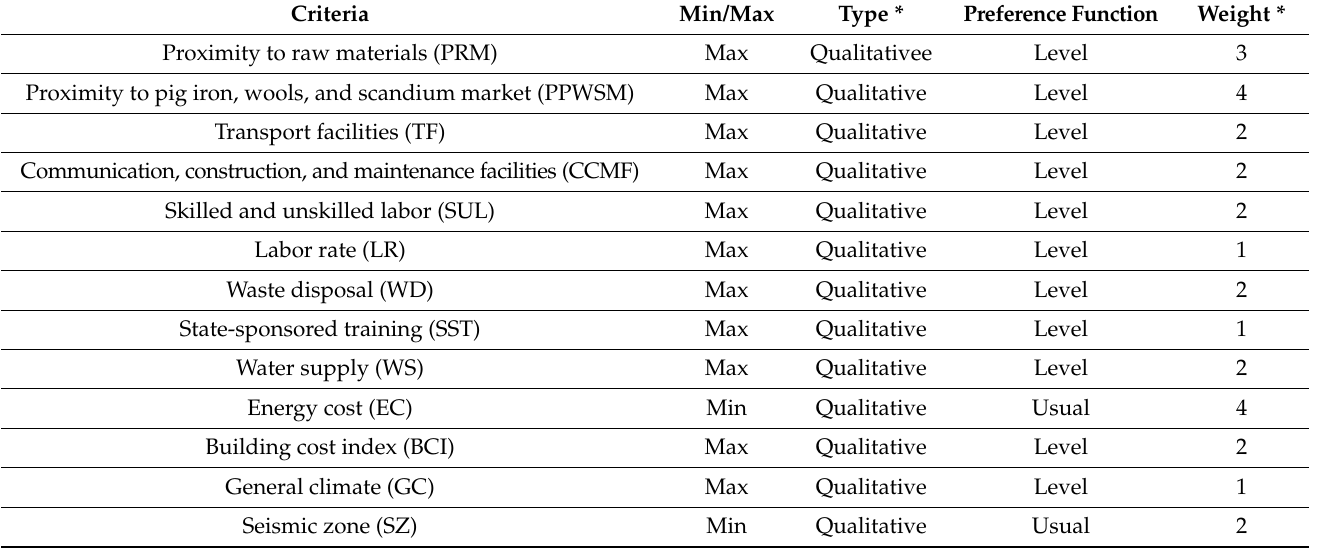
Table 1. Criteria for pilot plant